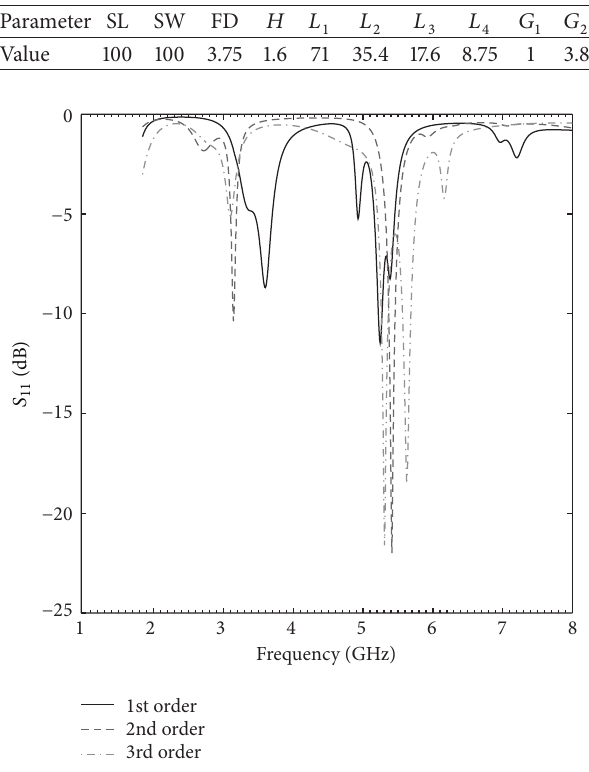
Figure 2: Simulated reflection coefficients ( 𝑆 11 ) of the proposed